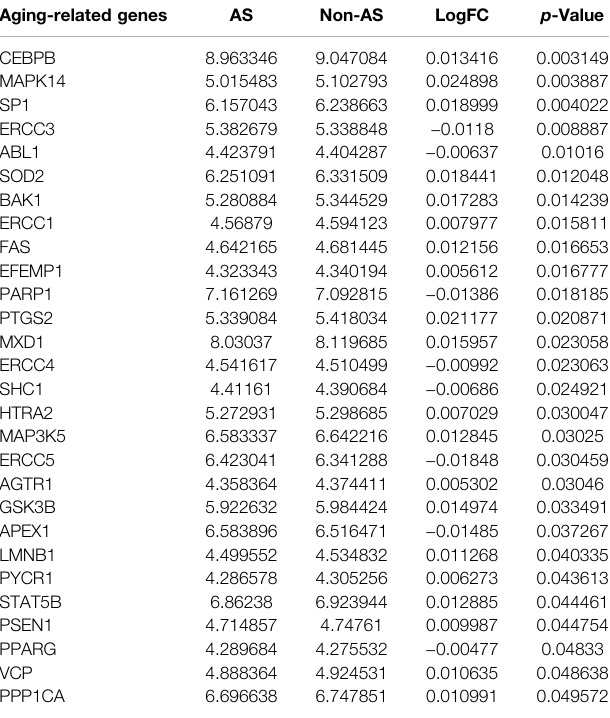
TABLE 2 | AS-speci fi c aging-related genes. Aging-related